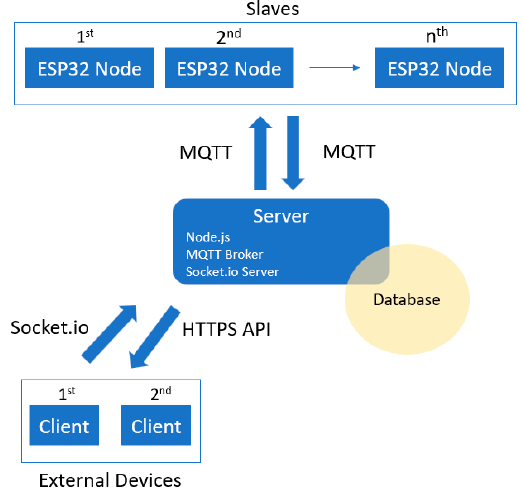
Figure 1. Protocol communication via Message Queuing Telemetry Transport (MQTT) in the proposed design.